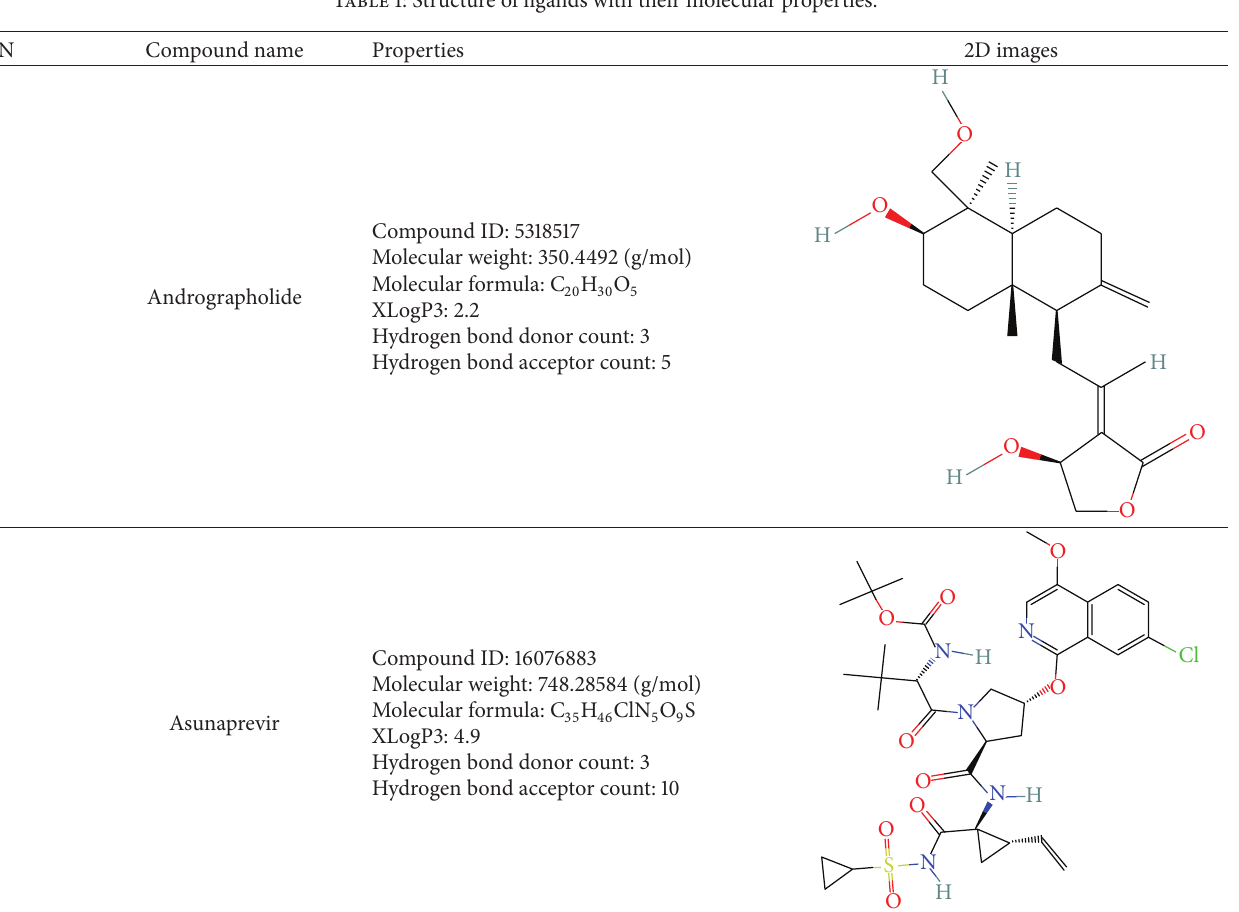
Table 1: Structure of ligands with their molecular properties.